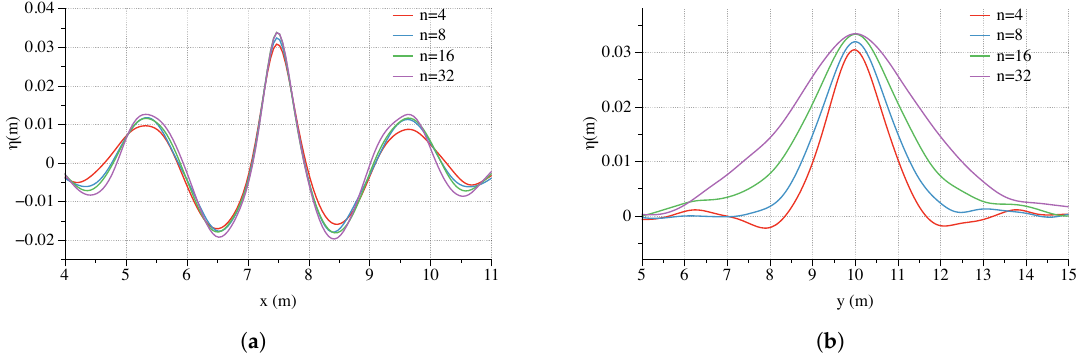
Figure 27. Comparison of the wave free surface elevations with four different spreading functions, ( a ) comparison of the wave profiles in the longitudinal x-z plane at y = 10 m, ( b ) comparison of wave profiles in the transverse y-z plane at x = 7.5